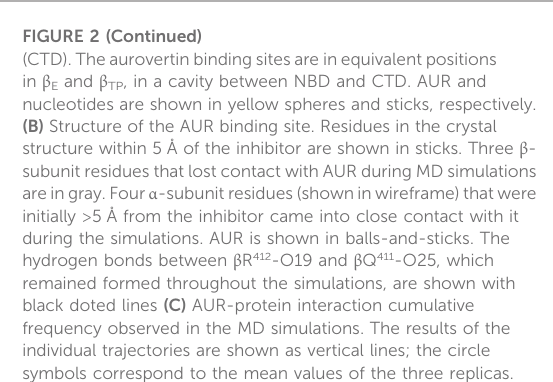
FIGURE 2 Contact analysis at the AUR binding site in β TP . In the crystal structure of BtF 1 complexed with AUR B (PDB ID: 1cow), one inhibitor molecule is bound to β TP and a second to β E . Only the β TP site is shown. (A) Both α and β subunits have a three-domain organization: a β -barrel N-terminal domain (NTD), a central nucleotide binding domain (NBD) and aC-terminal helical domain